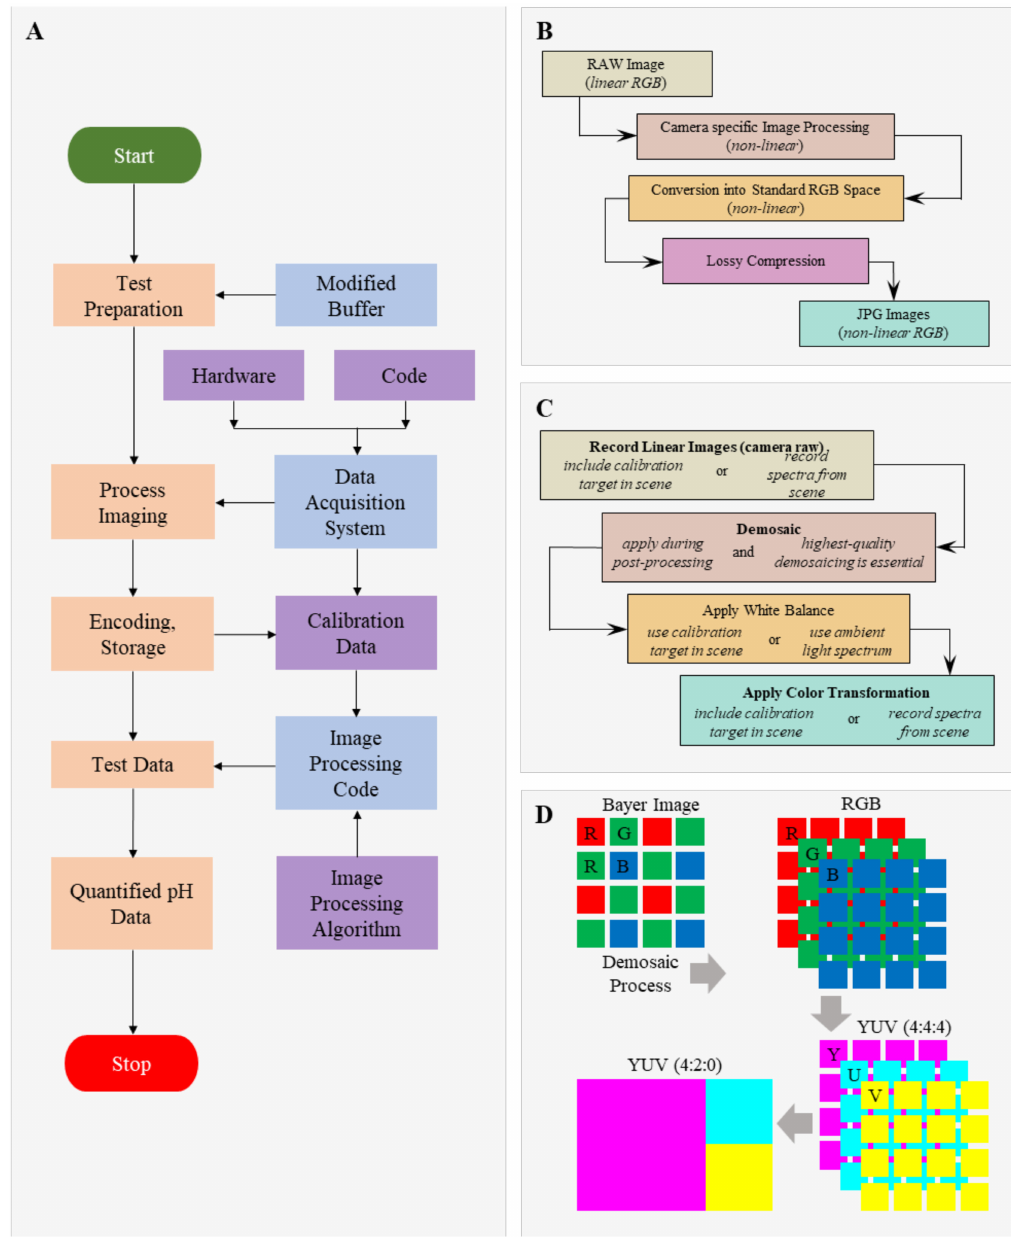
Figure 2. Flow-chart of data analysis for pH measurement. ( A ) Process flow-chart. ( B ) Image-processing algorithm for lossy compression. ( C ) Image-processing algorithm for loss-less processing. ( D ) Conversion of sensor data into YUV420 planar data format. This uncompressed linear format prevents any loss of data required for the image